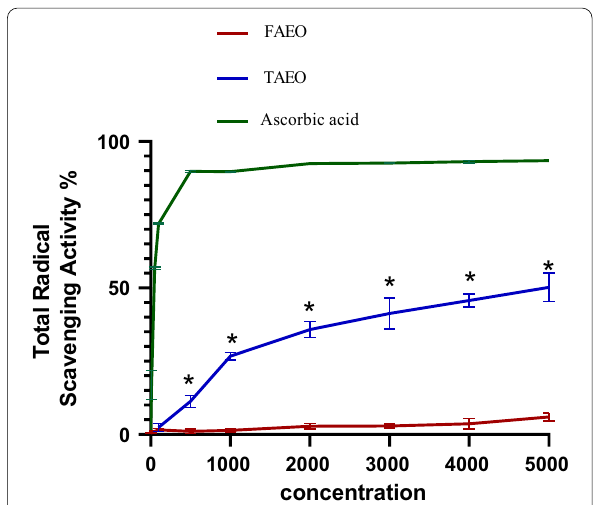
Fig. 1 Total radical scavenging activity of Trachyspermum ammi essential oil (TAEO), Ferula assafoetida essential oil (FAEO), and ascorbic